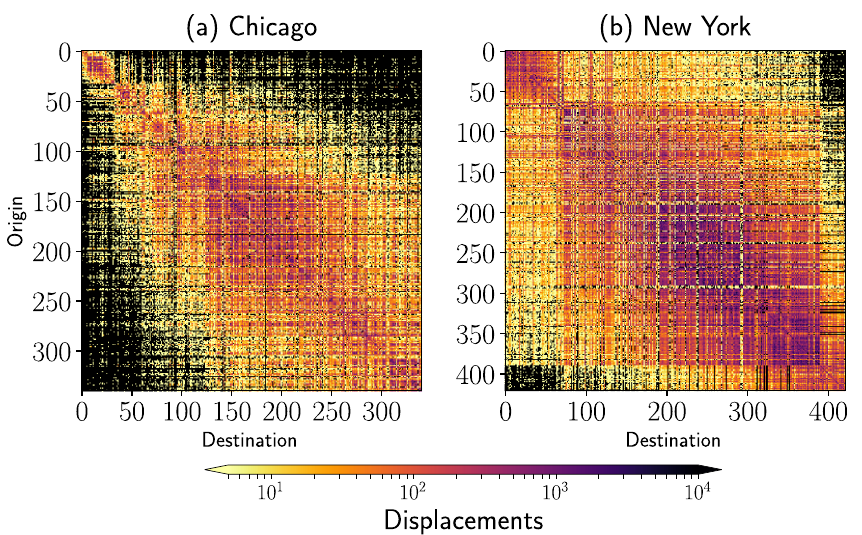
Fig 3. Origin-destination matrices for bike-sharing systems. We present the results obtained for the city of (a) Chicago ( N = 340) and (b) New York ( N = 421). The geographical coordinates (longitude, latitude) of stations are sorted starting from the southern locations and considering the order of longitudes from west to east. The number of displacements or trips between origin and destination stations is codified in logarithmic scale in the colorbar; null entries are represented in